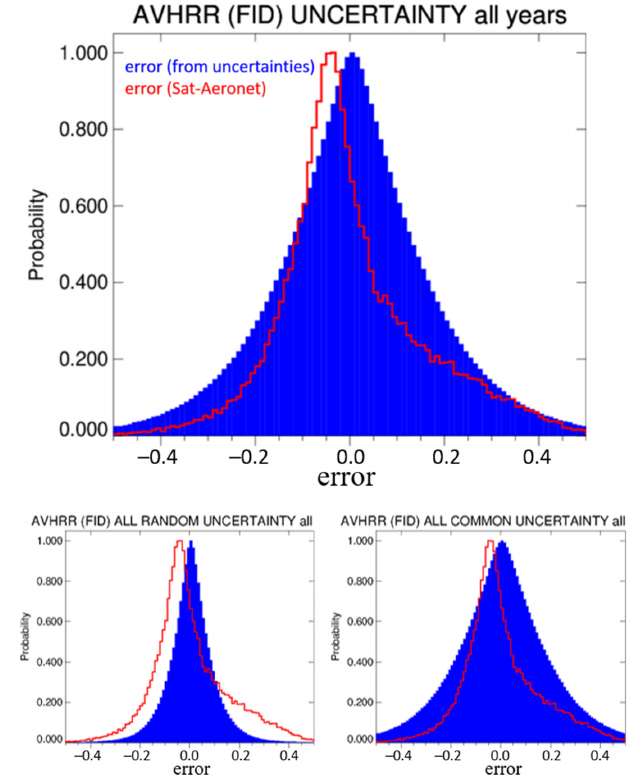
Figure 7. Probability distributions of the estimated true error vs. AERONET (in red) and errors derived from uncertainties (in blue) for the 10 year AVHRR AOD dataset. Top: distribution for propagated uncertainties; bottom: hypothetic distributions for “all random” ( left ) and “all common” ( right ) propagated uncertainties. Remote Sens. 2022 , 14 , 875 In order to assess the suitability of uncertainties to differentiate pixels with likely small from likely large errors, in Figure 8, we plot three percentile values (38%, 68%, 95%) of the absolute error distributions for each (binned) value of the uncertainties (following [8])—this is representative of plotting the full error histograms along the y ‐ axis along each value of the associated propagated uncertainty at the x ‐ axis. These three percentage values should lie along linear functions with gradients of 0.5, 1, and 2. Most points with u(AOD) between 0.05 and 0.25 lie close to the expected 1:0.5 and 1:1 lines, which indicates that their uncertainties are a meaningful predictor for the expected size of the errors. However, the points at the edges (left and right, and upper) are further away from them. The latter fact can be explained by low numbers in bins with very low ( u(AOD) < 0.05) and very high ( u(AOD ) > 0.25 uncertainty, as shown in Figure 7, and for normalized errors above 2 (the blue symbols in Figure 8); all these lead to high binning errors in the percentile values.